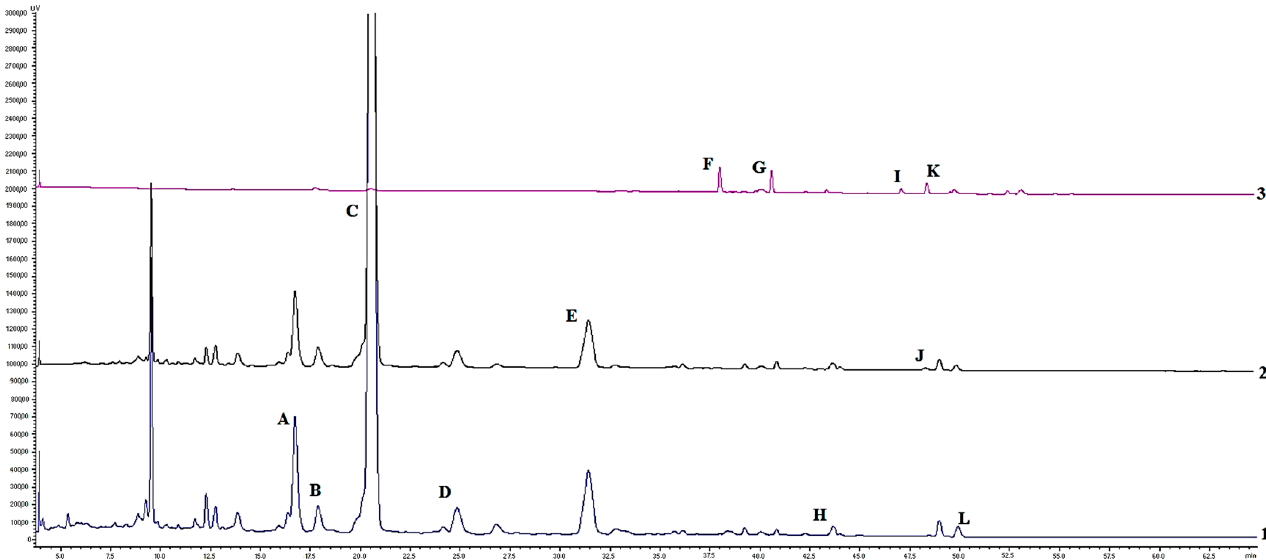
Figure 5. The chromatogram of C. sativus perianth fingerprints obtained by HPLC-DAD method at 270 nm (line 1), 310 nm (line 2), and 440 nm (line 3): mangiferin ( A ), isoorienthin ( B ), rutin ( C ), ferulic acid ( D ), isoquercitrin ( E ), tectoridin ( F ), crocin 4 ( G ), apigenin-7-glucoside ( H ), quercetin ( I ), nigricin ( J ), iristectorignin B ( K ), kaempferol ( L ). The HPLC method was validated for parameters such as linearity range, LoD, LoQ,